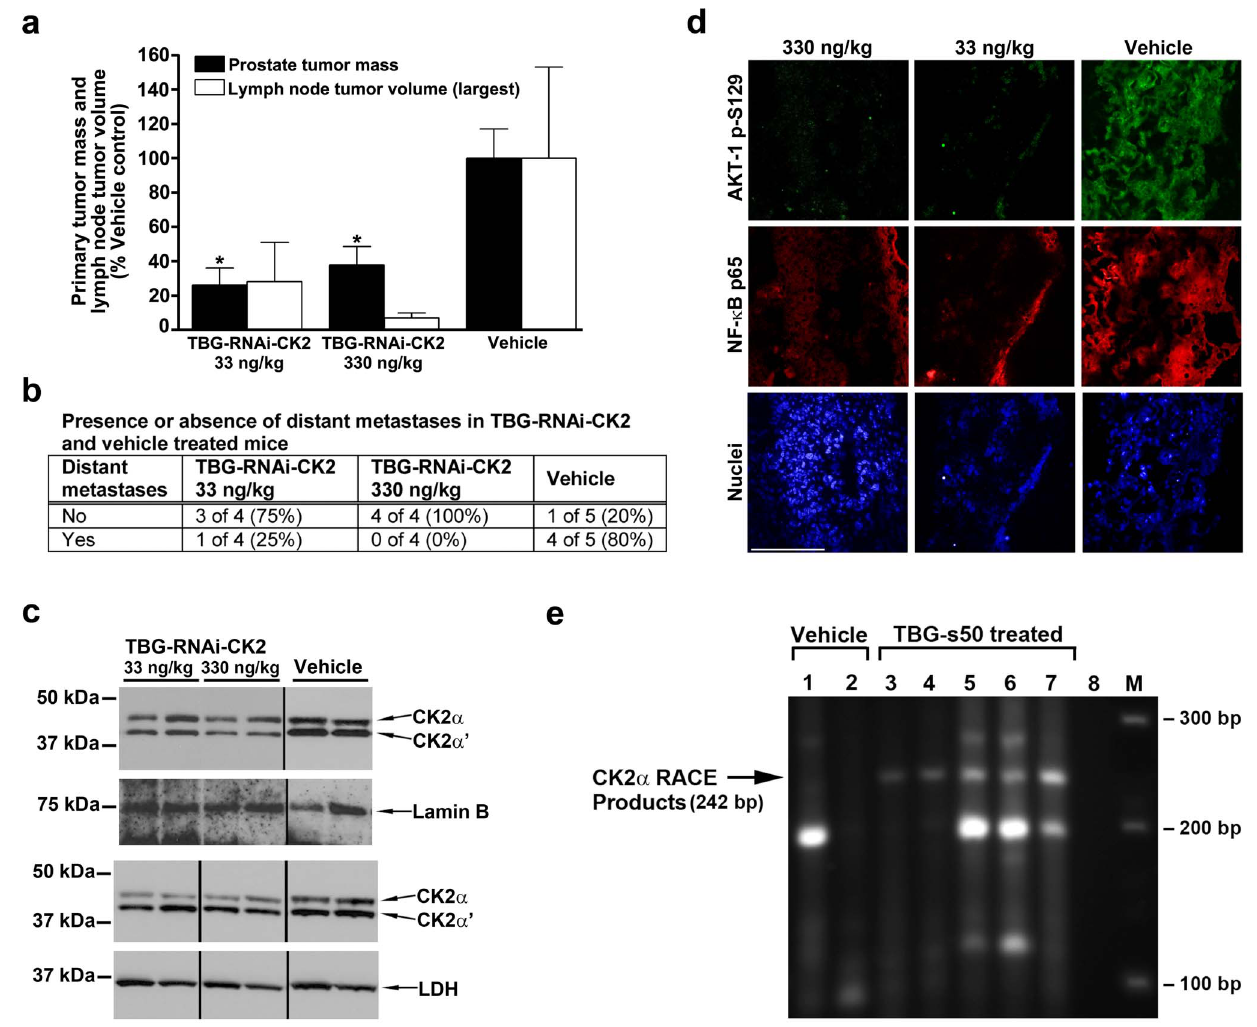
Figure 5. Proof-of-concept for therapeutic efficacy and mechanism of s50-TBG-RNAi-CK2 in orthotopic and metastatic prostate cancer xenograft tumors. ( a ) Primary tumor mass and lymph node tumor volumes are shown following s50-TBG-RNAi-CK2 treatments at 33 and 330 ng/kg compared to vehicle. Means 6 SE are presented (TBG-RNAi-CK2 n=4; Vehicle n=5). * p , 0.05. ( b ) Proportion of mice with distant metastatic tumors following s50-TBG-RNAi-CK2 treatments at 33 and 330 ng/kg compared to vehicle. Comparison using Fisher’s Exact Test p=0.046. ( c ) Immunoblot analysis for CK2 a and CK2 a ’ response in primary tumors. The upper panels represent 10 m g of nuclear matrix lysate with normalization to lamin B1. The lower panels represent 20 m g of cytosolic lysate with normalization to lactate dehydrogenase (LDH). ( d ) Protein and signaling response expression analysis in representative lymph node tumors. Lymph node tumor frozen sections were analyzed by indirect immunofluorescence co-staining for AKT-1 phospho-S129 (green) and NF- k B p65 (red). DNA counterstain is shown (blue). Scale bar 100 m m ( e ) CK2 a RISC cleavage products are present in s50-TBG-RNAi-CK2 treated tumors. Total RNA was isolated from tumor tissue and used for 5 9 -ligation mediated RACE to determine if RISC mediated cleavage of the CK2 a transcript occurred. Lanes 1 & 2, day-10 vehicle-treated flank tumors; Lane 3, day-5 s50- TBG-RNAi-CK2 treated flank tumor; Lane 4, day-6 s50-TBG-RNAi-CK2 treated flank tumor; Lane 5, day-10 s50-TBG-RNAi-CK2 treated flank tumor; Lane 6, day-10 s50-TBG-siCK2 treated flank tumor; Lane 7, day-6 s50-TBG-RNAi-CK2 treated orthotopic tumor; Lane 8, no cDNA water control; M, DNA size markers. The predicted 242 bp RACE product is indicated at left, the size in bp of the DNA standards shown on the right and the treatment administered indicated above the